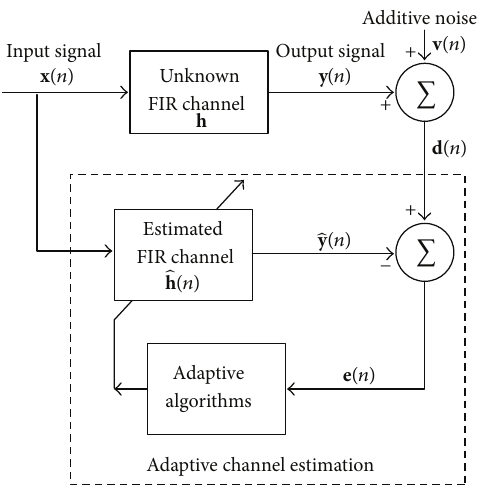
Figure 1: Typical sparse multipath communication